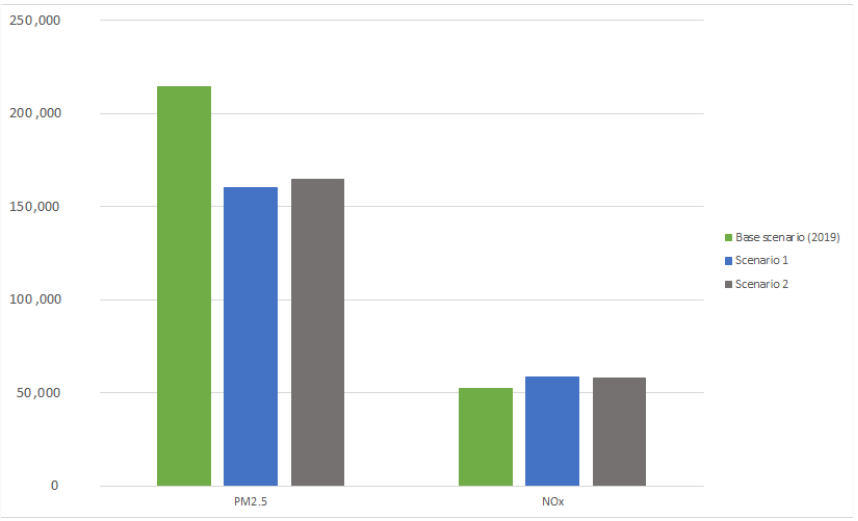
Figure 3. Total emissions of PM2.5 and NO 2 in base scenario, scenario 1, and scenario 2.